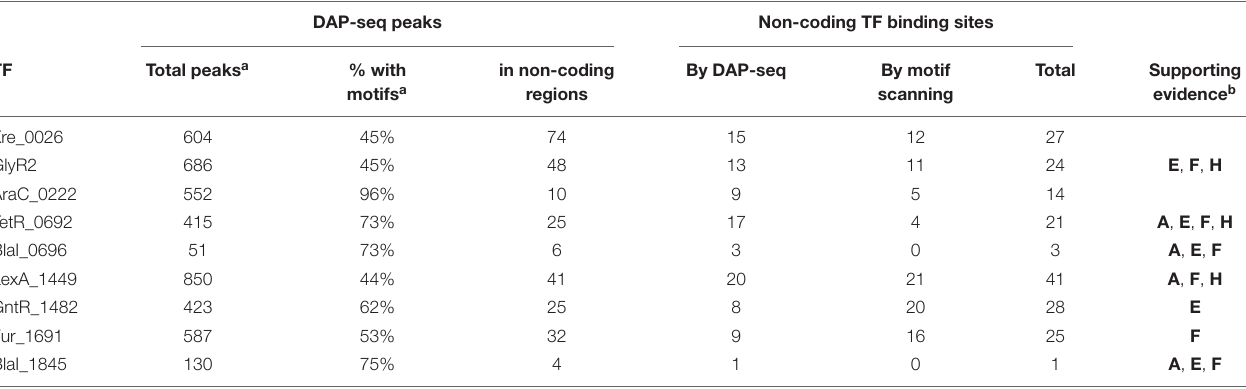
TABLE 3 | Summary of factors contributing to regulon reconstruction for each TF. DAP-seq peaks Non-coding TF binding